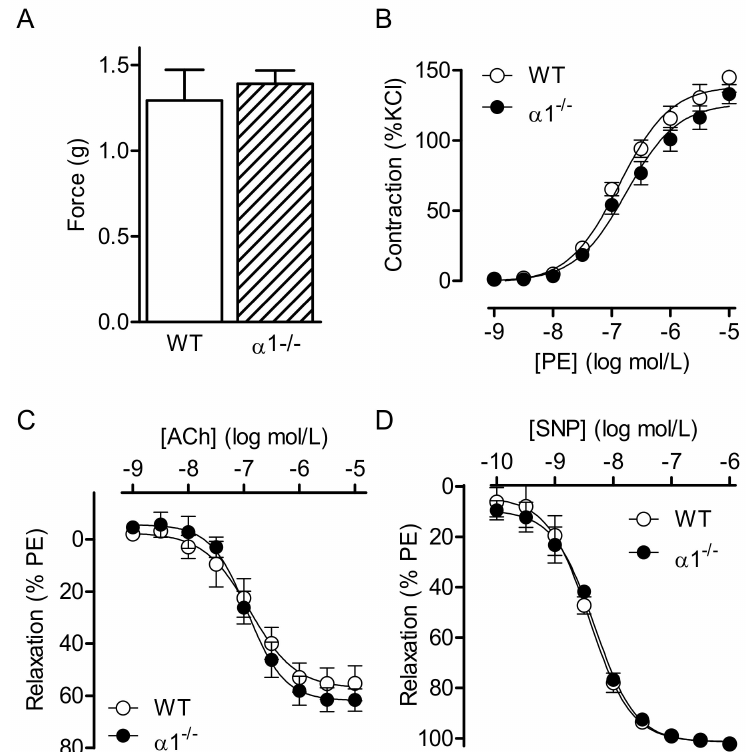
Figure 1. Consequences of global AMP-activated protein kinase (AMPK) α 1 deletion on vascular reactivity. Vascular reactivity in aortic rings from wild-type (WT) and AMPK α 1 − / − ( α 1 − / − ) mice. ( A ) Responsiveness of endothelium-intact aortic rings to KCl (80 mmol/L). ( B – D ) Concentration–response curves to ( B ) phenylephrine (PE), ( C ) acetylcholine (ACh), and ( D ) sodium nitroprusside (SNP). The graphs summarize data obtained from seven animals in each group.